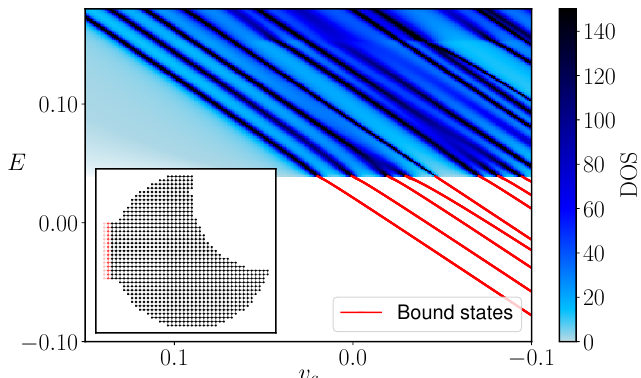
Figure 6: Same as Fig. 4, but with a chaotic scattering